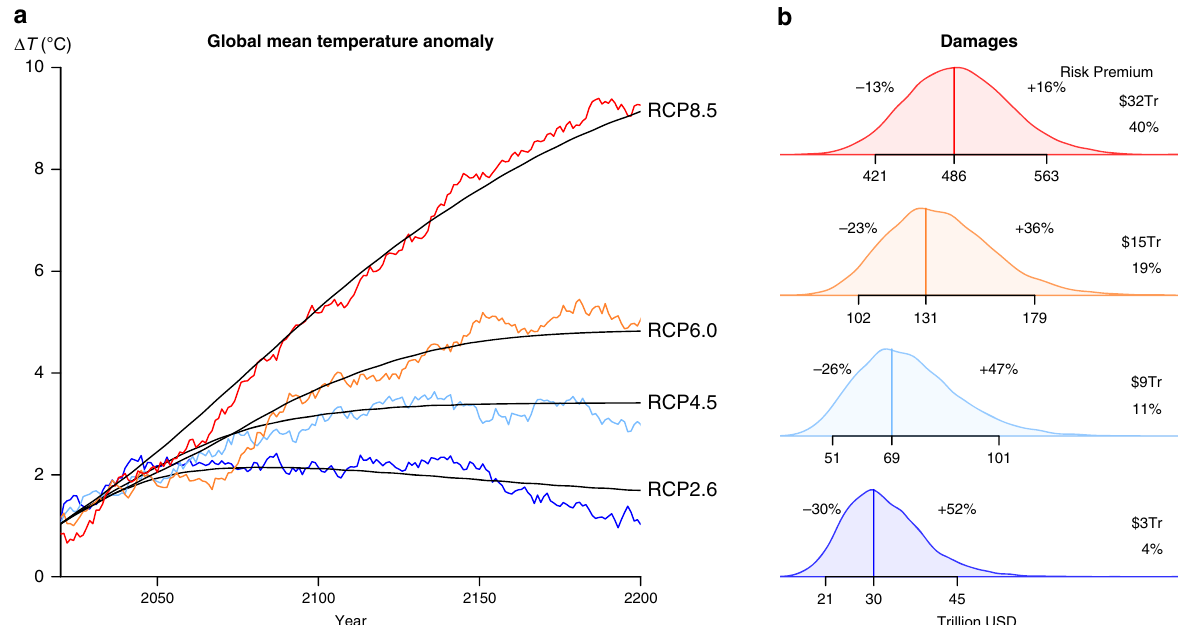
Fig. 2 Damages with deterministic and stochastic temperatures. a Temperature trajectories produced by the deterministic model (in black) and from a single run of the stochastic model (in colour) with forcings taken from RCP8.5, 6.0, 4.5, and 2.6 (from top to bottom). We assume C = 10 9 Jm − 2 K − 1 , λ = 1.23 Wm − 2 K − 1 , and σ Q = 0.9375 × 10 8 Wm − 2 s ½ , to approximate historical variability. b The distributions of damages obtained from ensembles of 10,000 temperature trajectories and a discount rate of 4.25% (to match 16 ). The deterministic damages as well as the 5 – 95% range for the damage distribution are noted along the axis. The risk premia are included along the right edge, telling us what the canonical social planner (also with a 4.25% discount rate) would in principle be willing to pay to avoid inter-annual temperature variability, measured both in current dollars and as a share of current global output. See Supplementary Note 5 for a description of these calculations, Supplementary Note 6 for a discussion of the parameter choices, and Supplementary Note 7 for sensitivity